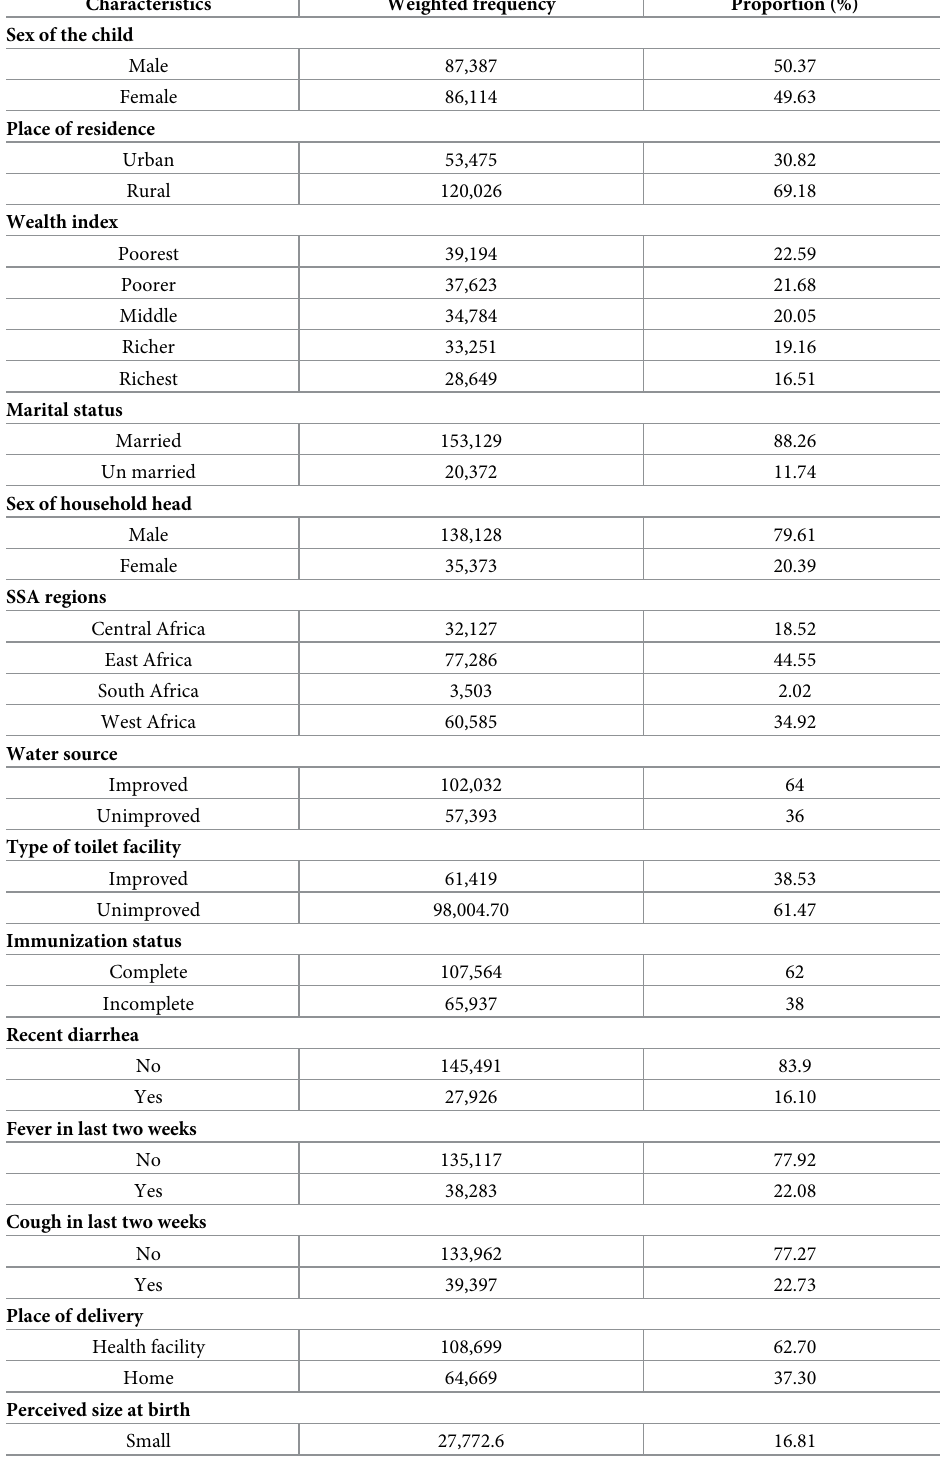
Table 1. Socio demographic, economic and Health related and/obstetrical characteristics of children and mothers; from recent DHS data of 35 SSA counties,